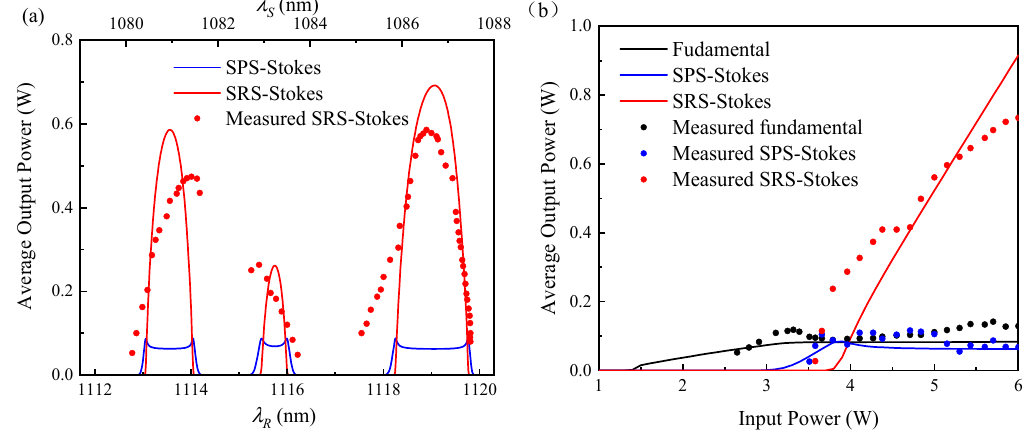
Figure 3. ( a ) Output power of the SRS-Stokes wave as a function of wavelength. ( b ) Output powers as functions of pump power.